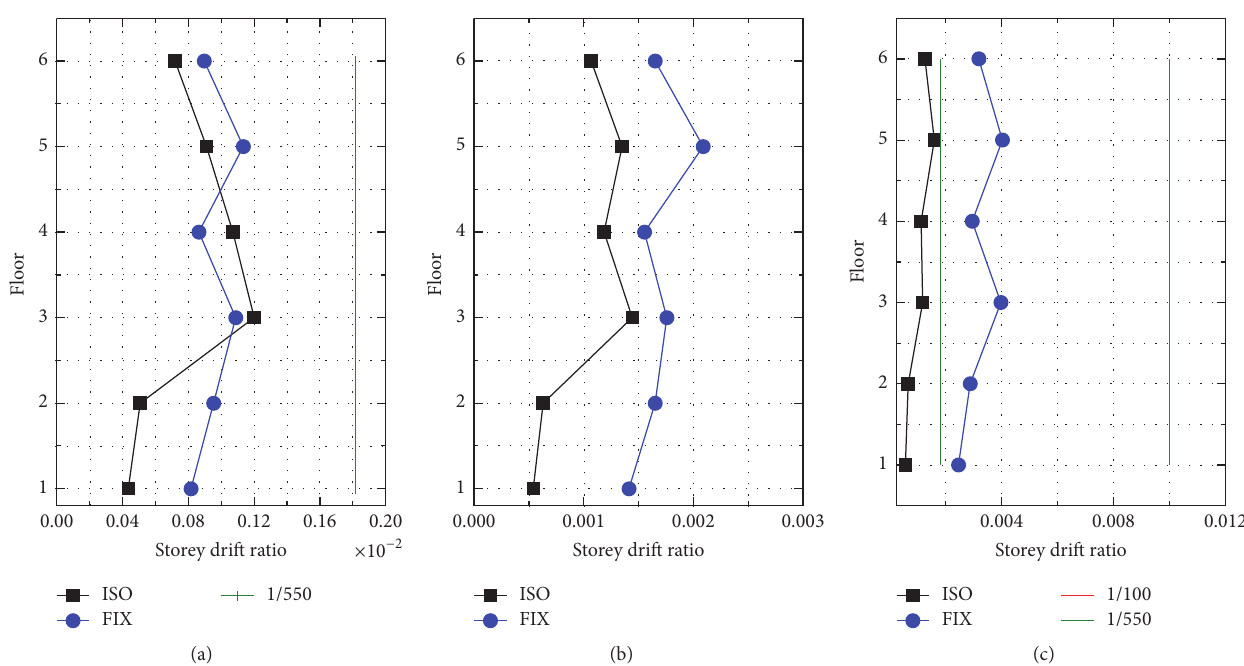
Figure 24: Story drift ratios of superstructure under earthquakes of different intensities: (a) minor earthquake; (b) moderate earthquake; and (c) major earthquake.